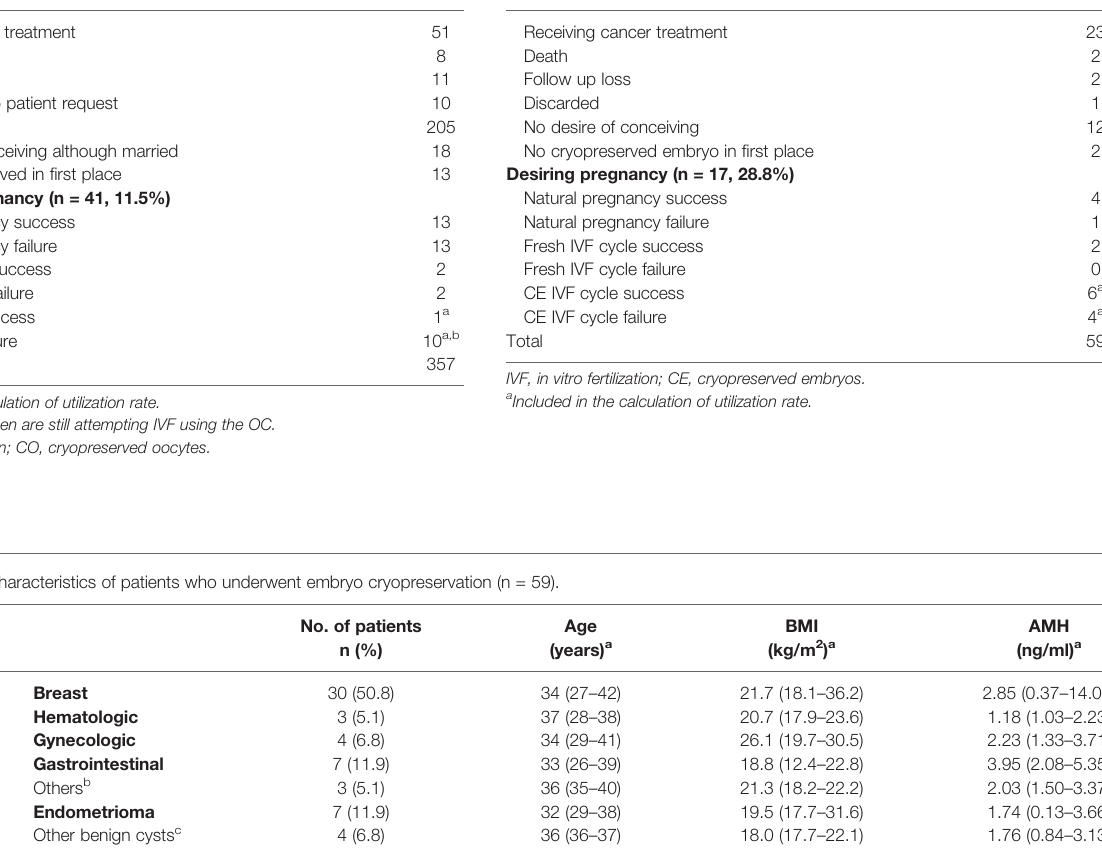
TABLE 4 | Current status of patients who underwent embryo cryopreservation and its utilization. Not attempting to conceive yet (n = 42,